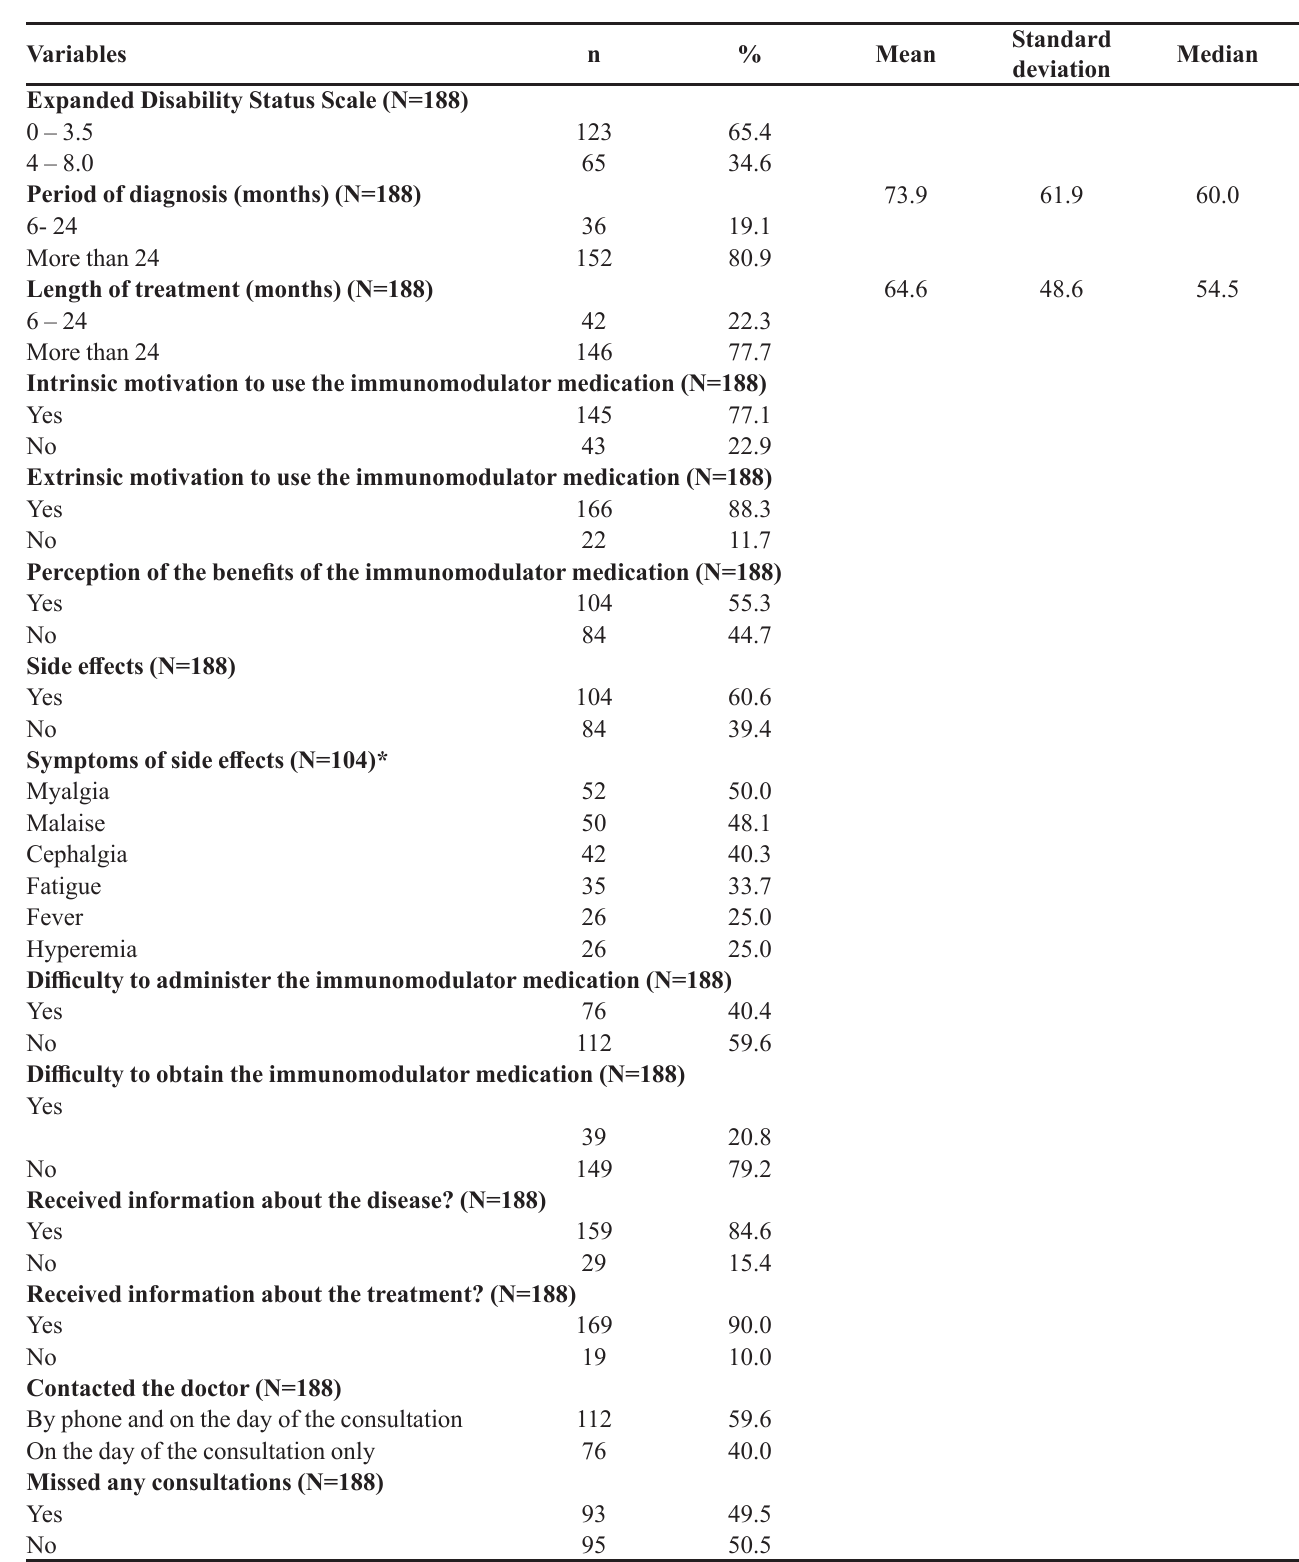
TABLE II - Aspects related to the disease and treatment of patients with multiple sclerosis receiving care in Reference Centers. Ceará, 2012 Variables n % Mean